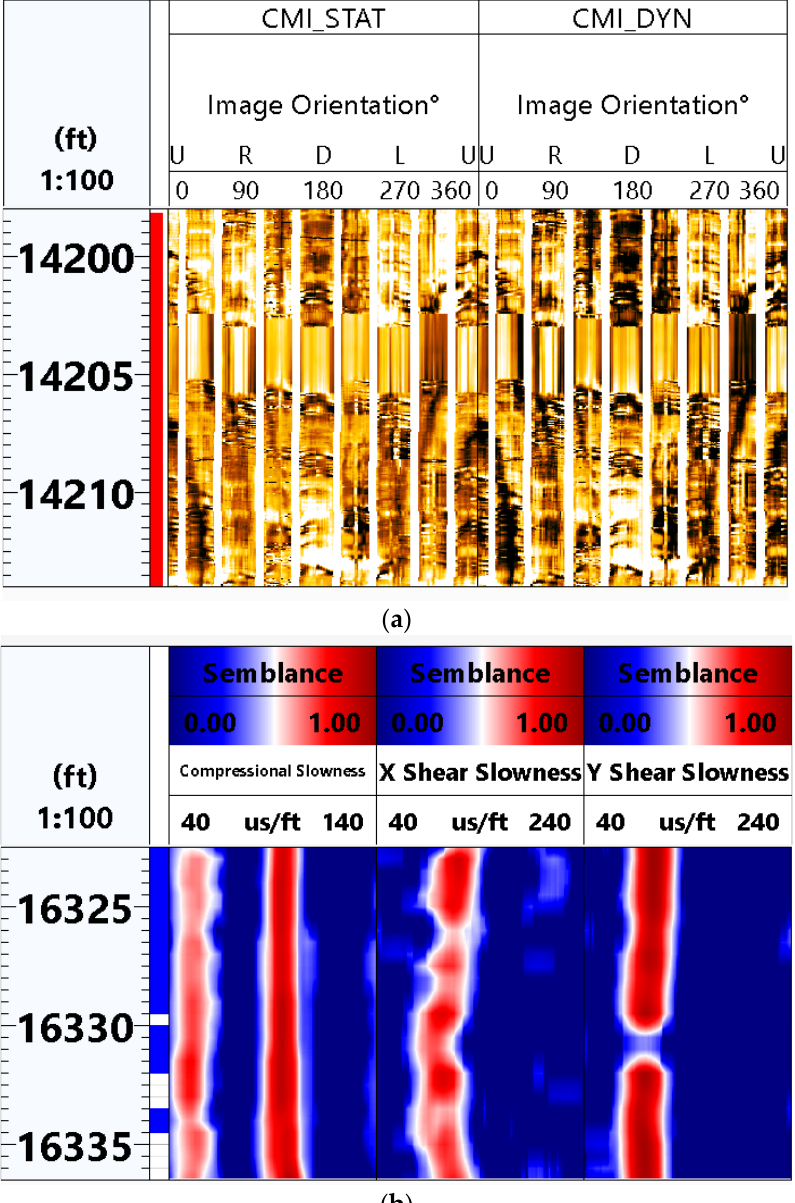
Figure 1. Examples of ( a ) image quality issues due to stick and pull along with cuttings interference causing an image quality where bedding is visible, but fracture identification is difficult, and ( b ) acoustic quality issues due to borehole rugosity and mud cake.